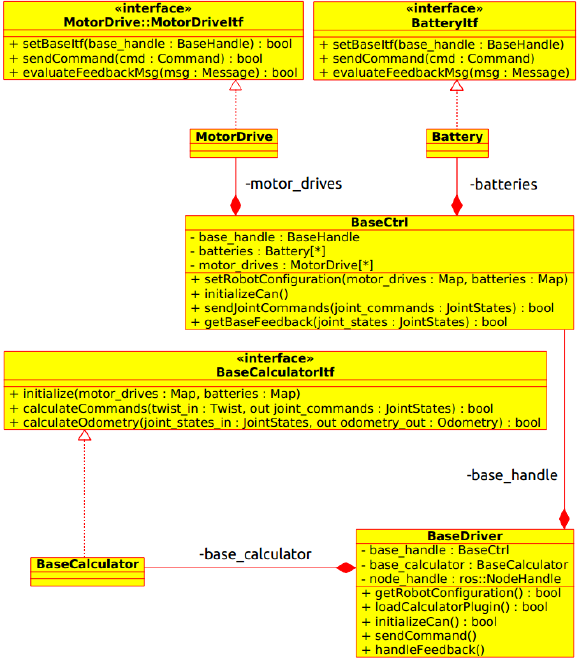
Figure 6: Simplified diagram of the BaseDriver